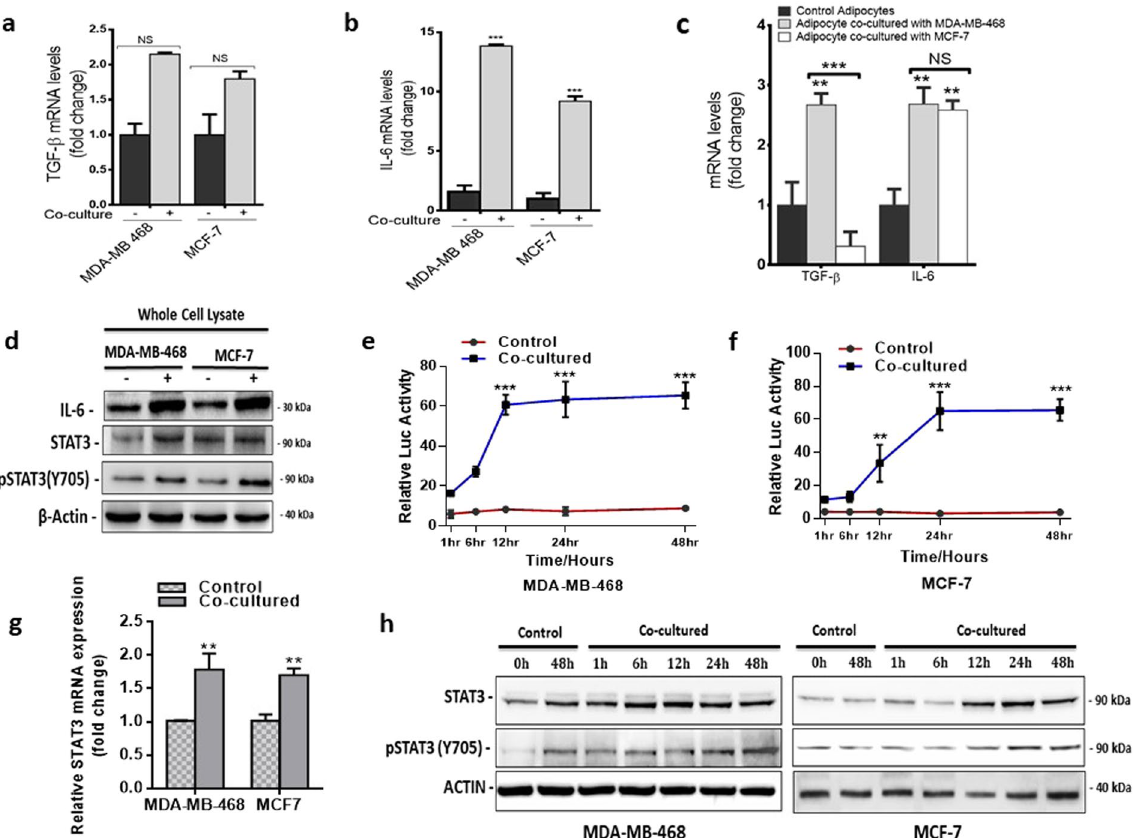
Figure 4. Analysis of STAT3 activity in breast cancer cells. ( a,b ) Quantitative PCR comparing the expression of TGF-B and IL-6 in co-cultured breast cancer cells to control cells. ( c ) qt-PCR comparing the expression of TGF-B and IL-6 in adipocytes cultured with/without breast cancer cells. ( d ) Comparing the expression levels of IL-6, STAT3 and pSTAT3 (Y705) in co-cultured and control breast cancer cells by immunoblotting. Full-length blots are presented in Supplementary Fig. 5. ( e,f ) Relative luciferase activity in breast cancer cells with STAT3 luciferase reporter plasmid and cultured with/without human adipocytes ( e ). MDA-MB-468 STAT3 activity, ( f ). MCF-7 STAT3 activity. Luciferase activity was normalized against a non-inducible luciferase construct. ( i ) Western blot for STAT3 and pSTAT3 (Y705) over 48 hours are regular time intervals in breast cancer cells cultured with/without adipocytes. B-actin was used as loading control. Full-length blots are presented in Supplementary Fig. 5. All results are representative of 3 independent experiments. Data is presented as mean ± SEM; *** p < 0,001; ** p < 0.01; * p <